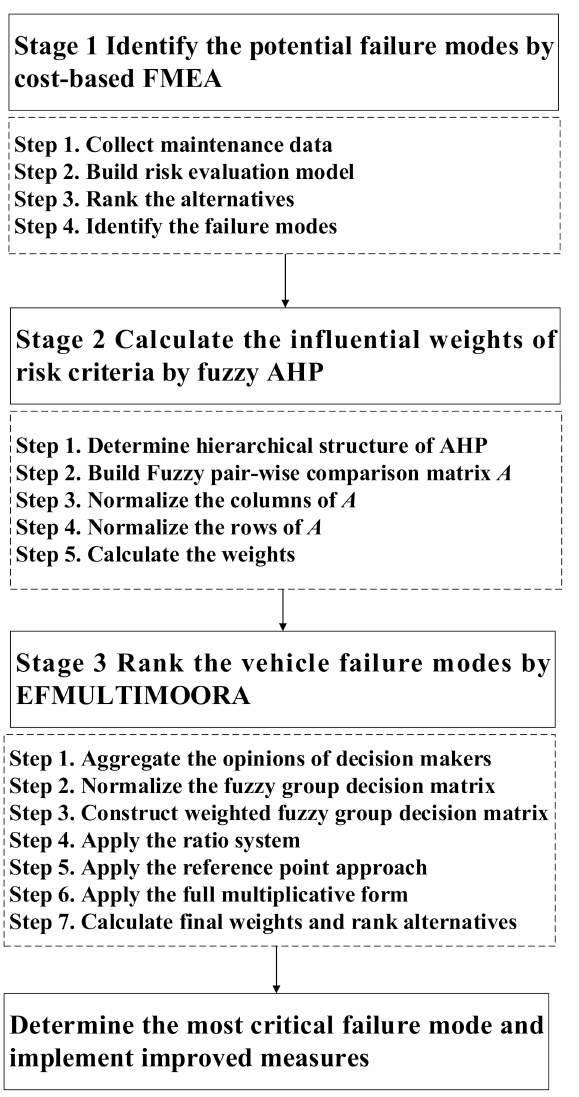
Figure 2. Flowchart of the proposed hybrid evaluation